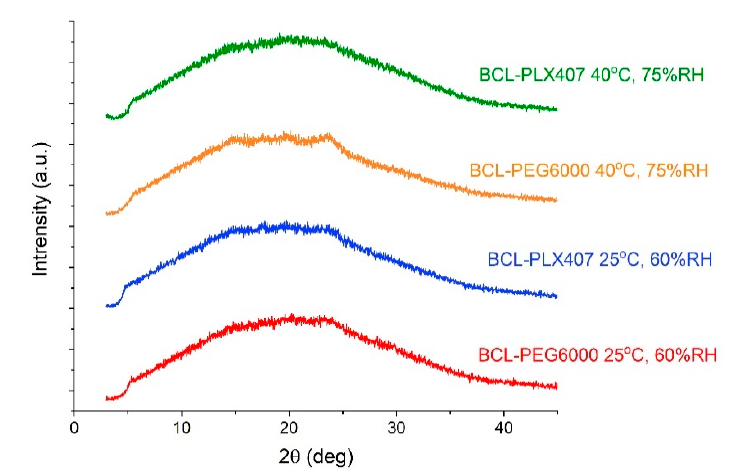
Figure 9. Diffraction patterns of bicalutamide in tablets with solid dispersions after stability studies.